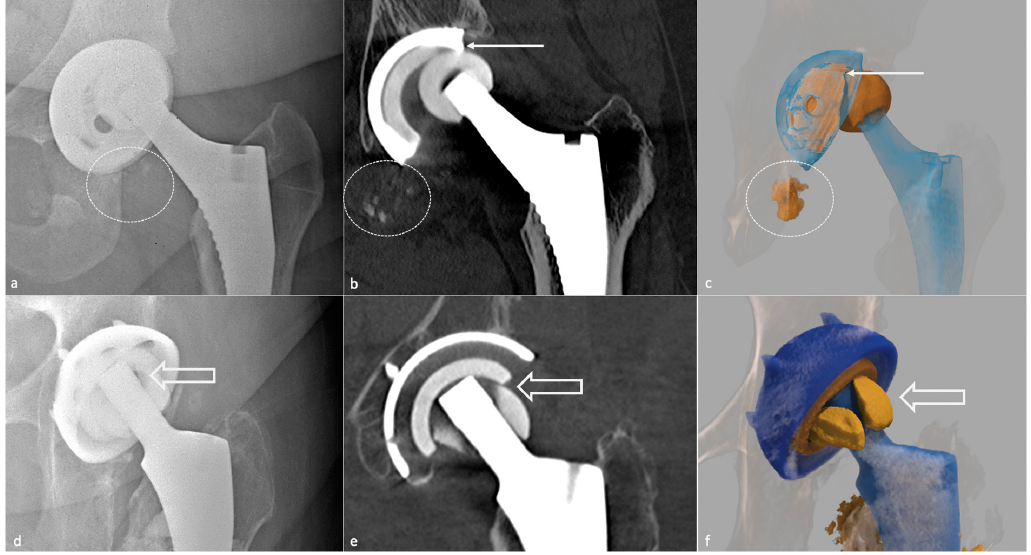
Figure 22. Ceramic fractures. An acetabular liner fracture is shown on ( a ) an anteroposterior hip radiograph, ( b ) a coronal CT ‐ scan slice, and ( c ) a global illumination reformat with femoral head exenteration. The fracture is better depicted in ( b , c ) (white arrow), and ceramic debris can be seen on ( a – c ) (dotted circle). A femoral head fracture in a case of sandwich ceramic liner is shown on ( d ) an anteroposterior hip radiograph, ( e ) a coronal CT ‐ scan slice (thick white arrow), and ( f ) a global illumination reformat. Note the interposition of a radiolucent space between the metal back and the ceramic liner due to the presence of PE, best seen on the CT ‐ scan image. ponents used to reconstruct an acetabular socket might be carefully analyzed, as local